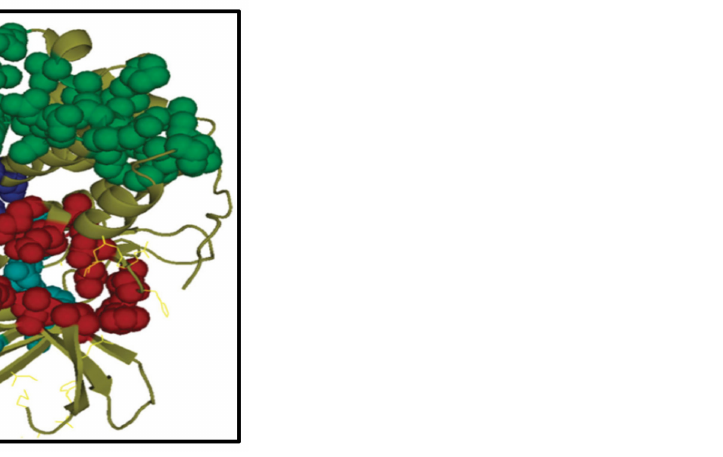
Figure 6. The four binding sites of CDK2A. ATP attachment pocket (site I) indicated in red, the second II and third sites III are indicated by green and blue, respectively. The allosteric site (fourth site IV) is indicated in cyan. Table 5. Results of molecular adhesion of the most active compounds ( 6b, 6d–g , and 7b ) versus CDK-2A (PDB ID: 5ANJ).